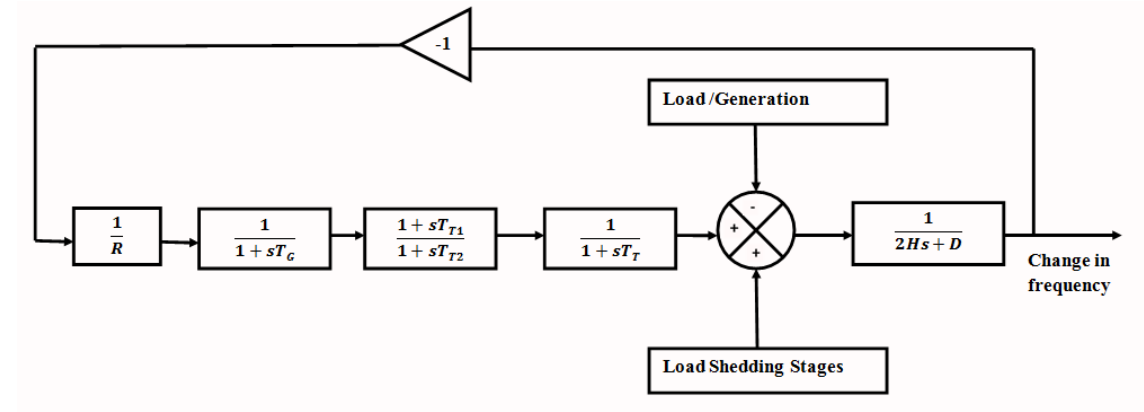
Figure 2 : Single busbar model used for the